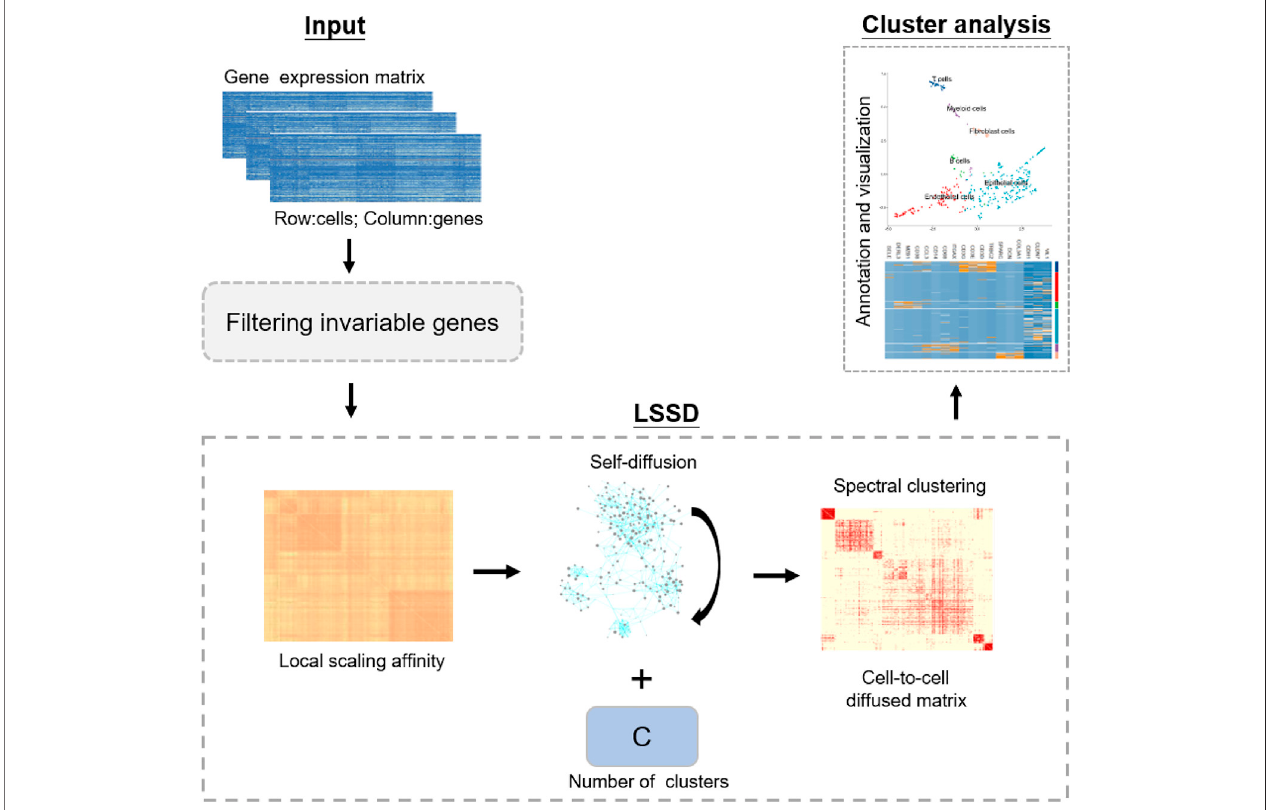
FIGURE 1 | Schematic of our approach, LSSD work fl ow. LSSD performs self-diffusion on the local scaling af fi nity constructed by scRNA-seq data. The diffused graph enables effective clustering with C separable cell populations, followed by cell type annotation and visualization.